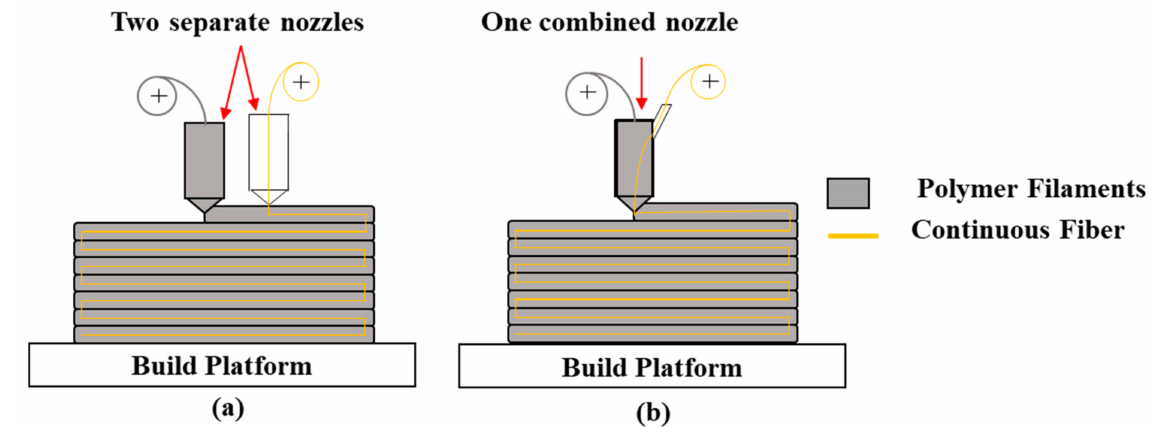
Figure 6. Fused filament fabrication (FFF) process for continuous fiber composite filament with ( a ) dual nozzles ( b ) sin- gle